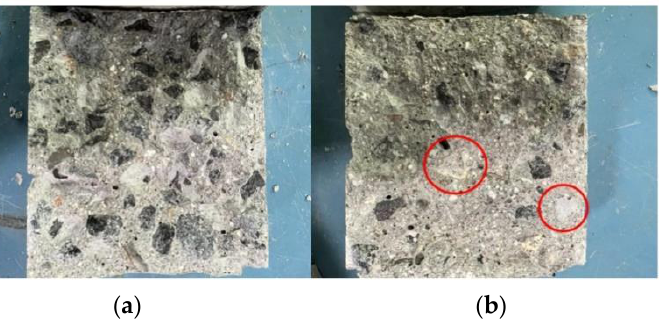
Figure 10. Internal structural morphology of NC and RC concrete. ( a ) NC. ( b ) RC.